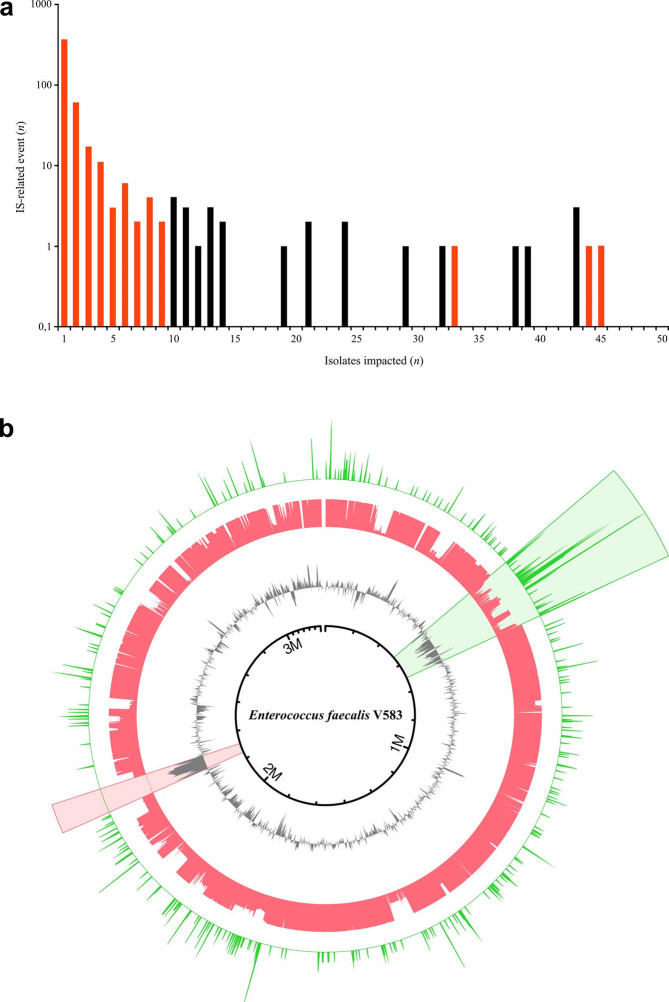
Distribution of the IS-related events in the genomes of a collection of 168 clinical isolates of
E. faecalis
 [11]. (a) Distribution of the number of IS-related events as a function of the number of isolates affected. The y-axis is drawn to a logarithmic scale. Red bars represent IS-related events that occurred >100 bp from a coding sequence or occurred in less than ten isolates. Black bars represent IS-related events that occurred within 100 bp of a coding sequence and are reported in Table 3. (b) The outer green circle represents the number of IS-related events, the red central circle indicates the number of genomes from the collection of 168 isolates of
E. faecalis
 containing the region, and the inner grey circle represents GC-content relative to the mean value. The 150 kb pathogenicity island and the ICE (ICEEEfaV583-1) of
E. faecalis
 V583 are indicated by the green and red sectors, respectively.